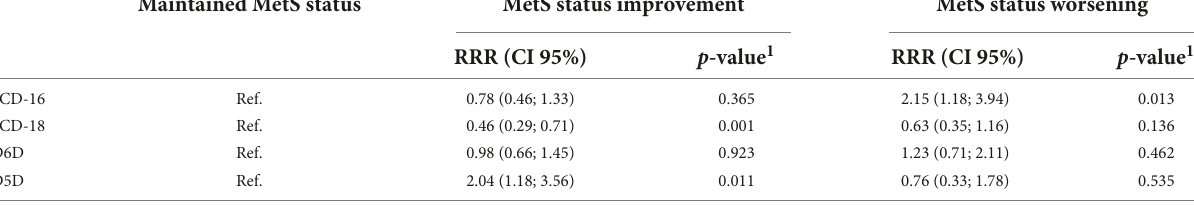
TABLE 5 Multinomial logistic regression for changes in MetS status and estimated DEA ratios after 1 year of follow-up per 1-SD increase. Maintained MetS